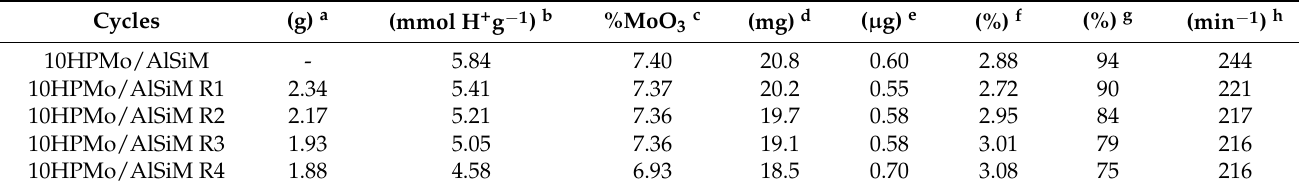
Table 2. Properties of acidity, leaching of active species and catalyst conversion during recycling.